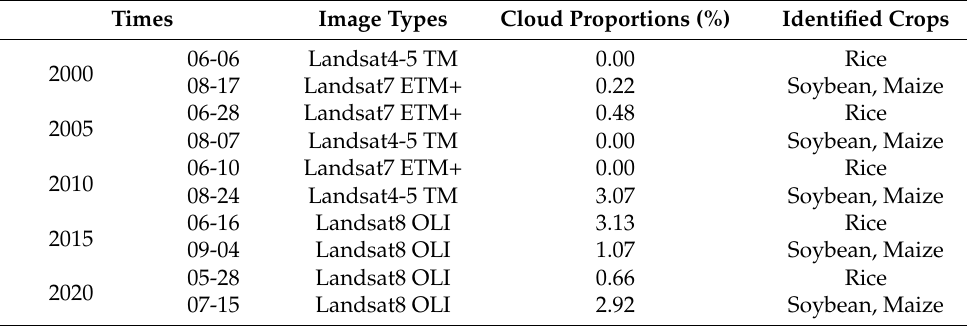
Table 1. Details of satellite